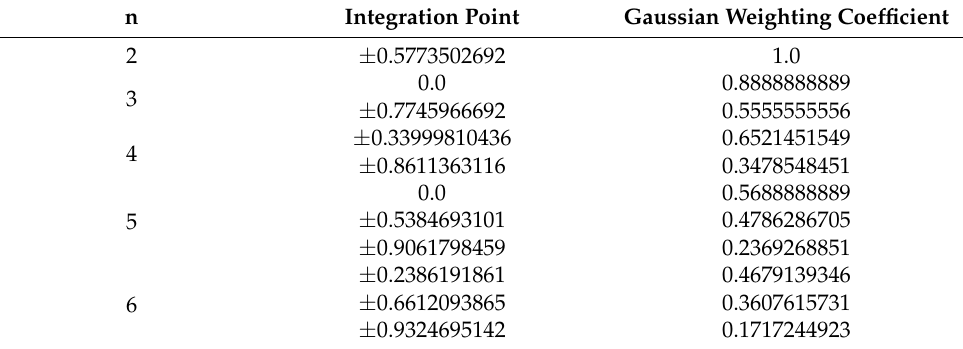
Table A1. Integration point (xi) and Gaussian weighting coefficient (Ai) of the Gauss–Legendre integral. (Reprinted with permission from Ref. [32]. Copyright 2021 Springer